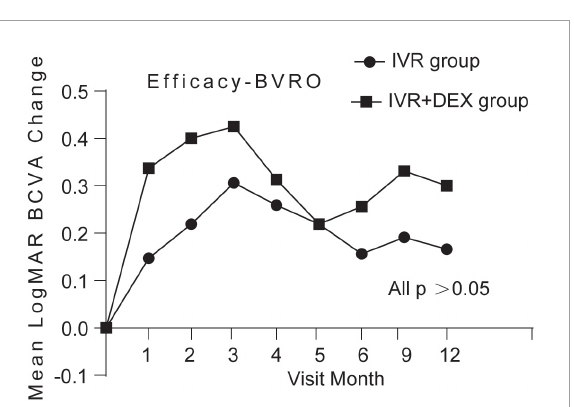
FIGURE2 Mean log MAR BCVA improvement over time compared to baseline: 12-month follow-up in both treatment groups after initial therapy in patients with CRVO.